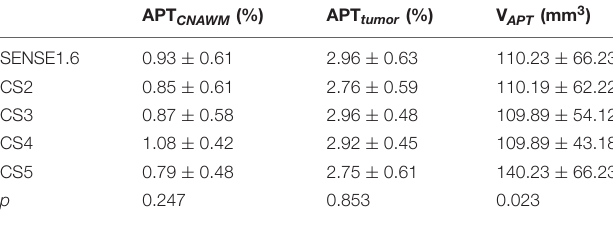
TABLE 5 | Comparisons of quantitative APT values for gliomas between CS-SENSE and SENSE